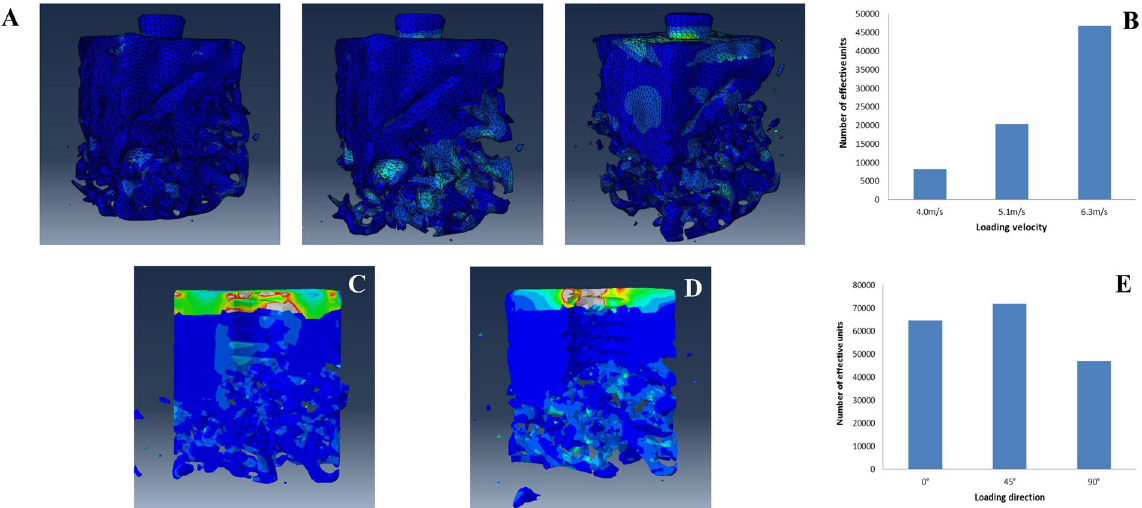
Figure 8. The relationship between bone damage and loading magnitude and loading direction. All the figures presented were from Abaqus 6.13 software (Dassault System, Simulia Corp, USA). ( A ) The effect of loading velocity (4.0 m/s;5.1 m/s;6.3 m/s) on damage. ( B ) The number of ineffective units in the model at a given loading velocity; ( C ) Horizontal impact loading. ( D ) Oblique impact loading at 45°. ( E ) The number of ineffective units in the model associated with a given loading